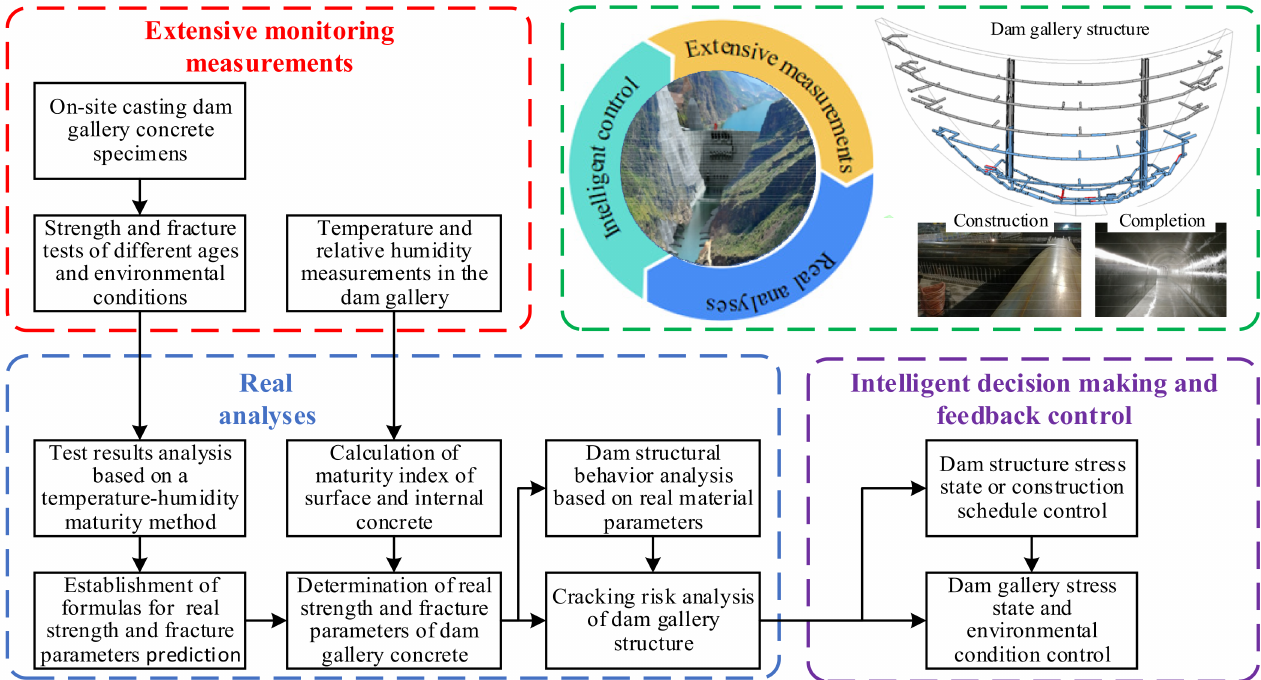
Figure 1. Determination and application method in intelligent dam construction platform (IDAM 2.0)